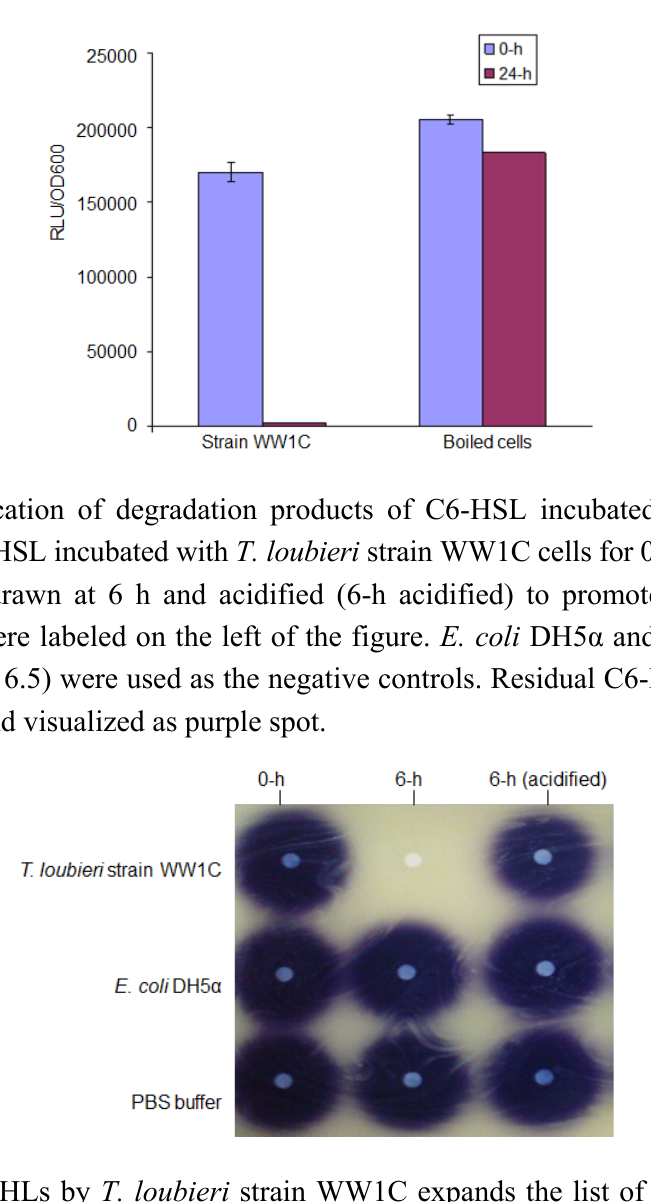
Figure 5. Analysis of C6-HSL after 0- and 24-h incubation with boiled and resting cells of T. loubieri strain WW1C. C6-HSL was incubated with boiled and resting cells of T. loubieri strain WW1C. Samples were withdrawn at 0 h (blue) and 24-h (purple), residual C6-HSL was detected by using the bioluminescent sensor strain E. coli (pSB401).